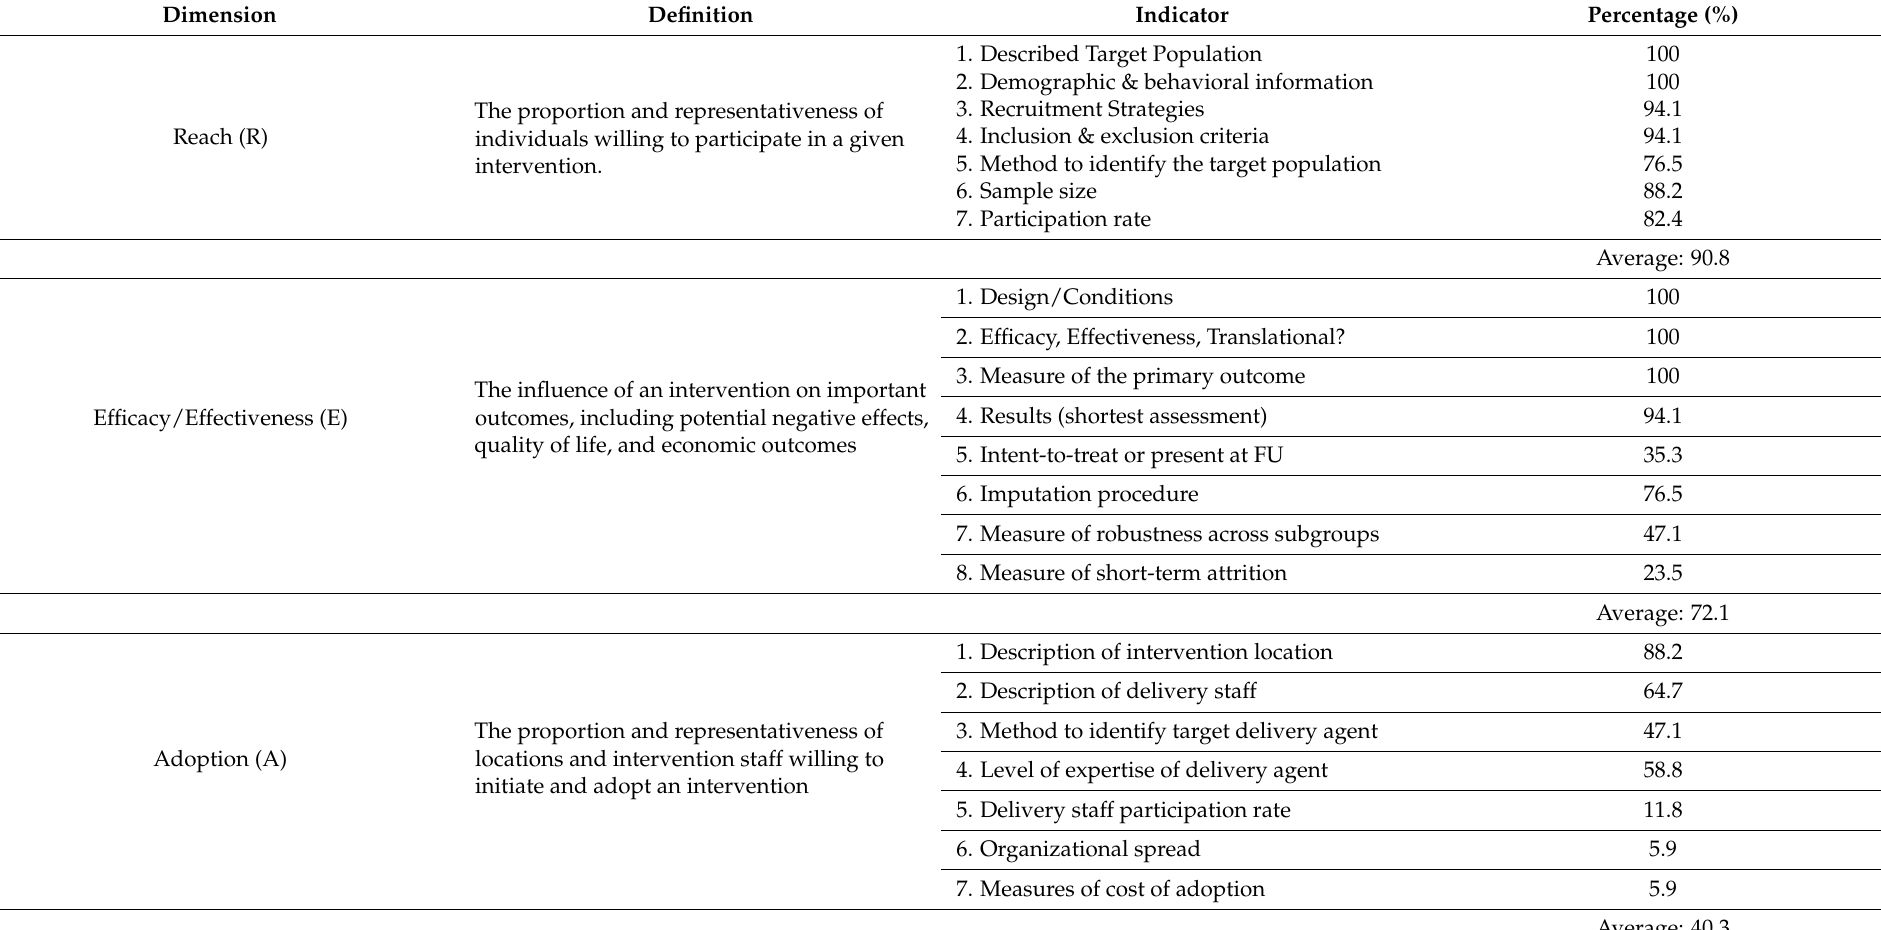
Table 1. Average scores for the RE-AIM dimensions and the scores for each 33-item indicator as used in the current study.